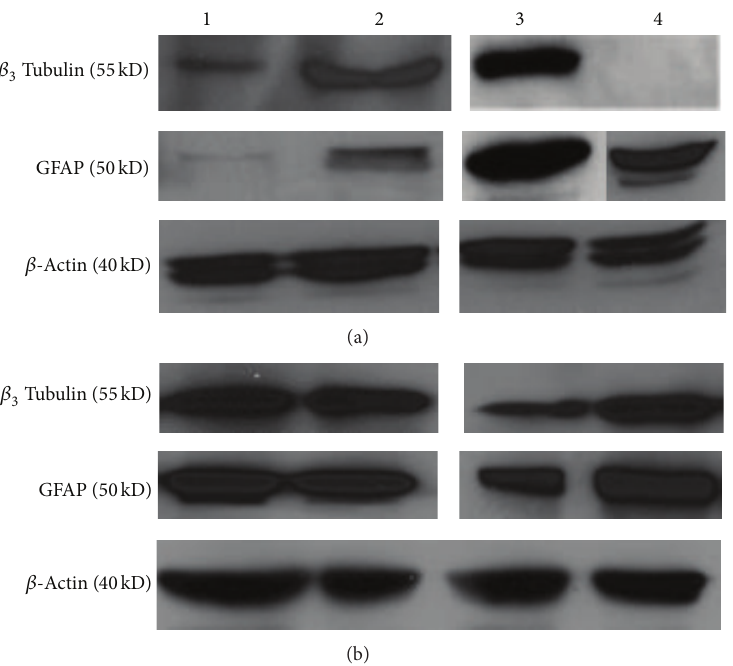
Figure 9: Expression of neural progenitor proteins by immunoblot analysis. Western blot analysis shows the expression of the neural progenitor proteins, 𝛽 3 tubulin and GFAP, in differentiated (a) and undifferentiated (b) eBM-MSCs generated from low and high passaged cells from middle-aged (lanes 1 and 2, resp.) and young (lanes 3 and 4, resp.) horses. Beta-actin was used as an internal control. 5 𝜇 g of protein was loaded per lane. It is interesting to note the expression of neural progenitor proteins in undifferentiated MSCs, suggesting that the plasticity of equine MSCs may go beyond extramesodermal